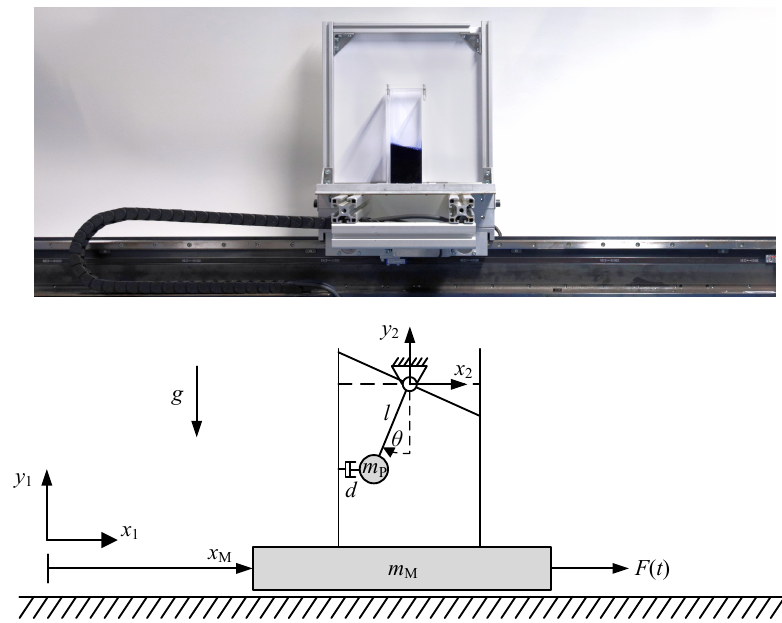
Figure 5. Mechanical motivation for model building due to abstracting the real process. The direct linear drive is described by a force actuated mass m M on which a damped pendulum with length l , mass m P , and damping coefficient d is mounted, which describes the fluid’s